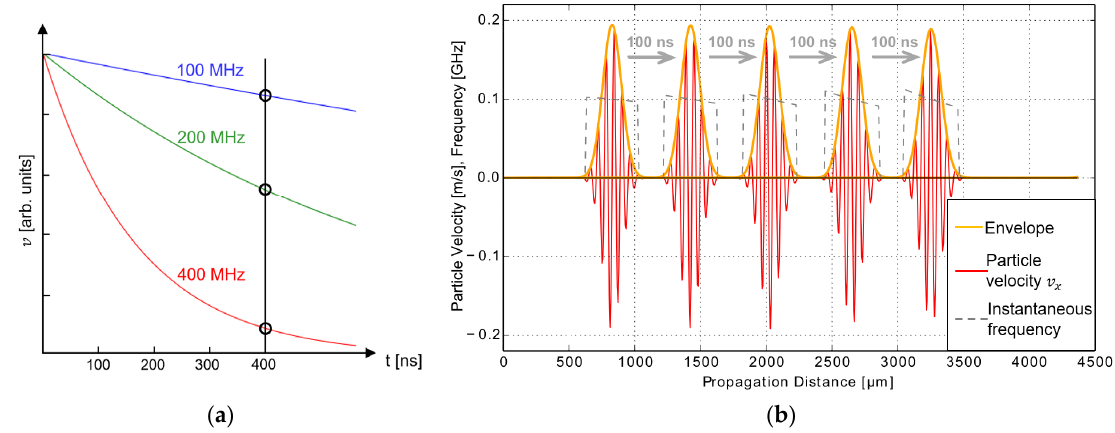
Figure 2. ( a ) The frequency estimator-based implementation of frequency-dependent damping shown for pressure wave propagation in water. ( b ) Propagation of a 100 MHz ultrasound pressure wave packet in aluminum. The instantaneous frequency computation reveals the numerical dispersion because a coarse spatial grid (10 grid points per wavelength) is chosen